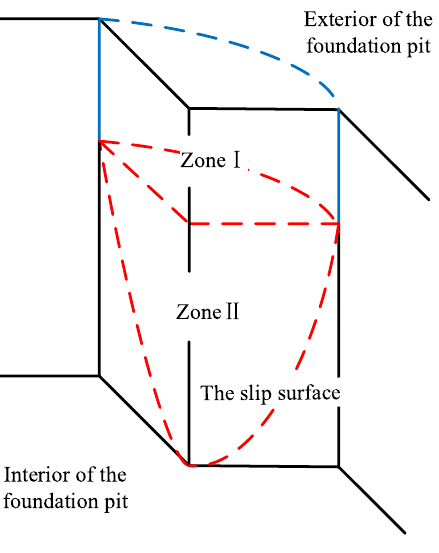
Figure 2. The failure mode of the external corner with equal lengths on both